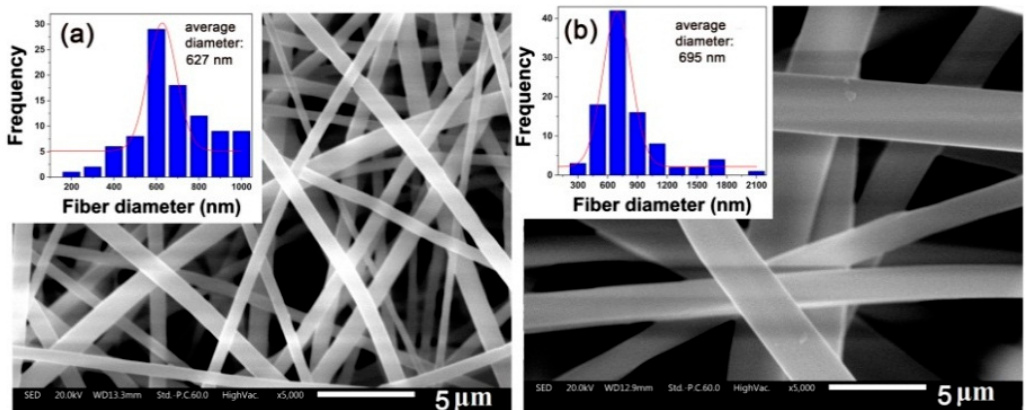
Figure 5. SEM images and average diameters ( d av ) of PI membranes. ( a ) PETI ‐ 10K; ( b ) PETI ‐ 20K.